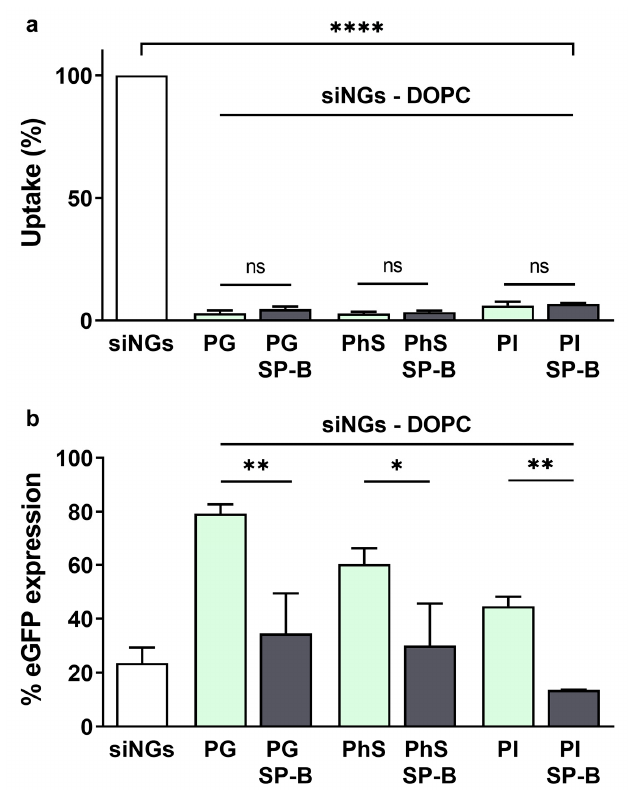
Figure 5. Role of the anionic lipid in biological efficacy of proteolipid-coated nanogels. ( a ) Cellular uptake and ( b ) gene silencing evaluated on H1299_eGFP cells via flow cytometry. SiRNA-loaded nanogels (siNGs) were coated with a mixture of DOPC:PG, DOPC:PhS or DOPC:PI (weight ratio 85:15). The presence of negatively charged lipids is required to allow the formation of the core-shell structure via electrostatic interactions. The replacement of the anionic phosphatidylglycerol (PG) with phosphatidylserine (PhS) or phosphatidylinositol (PI) does not abrogate SP-B’s beneficial effect on siRNA delivery. All experiments were performed with a fixed NG concentration (30 μ g/mL) and siRNA concentration (50 nM). Statistical analysis was performed via an unpaired t -test. Data are represented as the mean ± SD ( n = 3) and statistical significance is indicated (* p < 0.05, ** p < 0.01, **** p < 0.0001, ns = not significant).